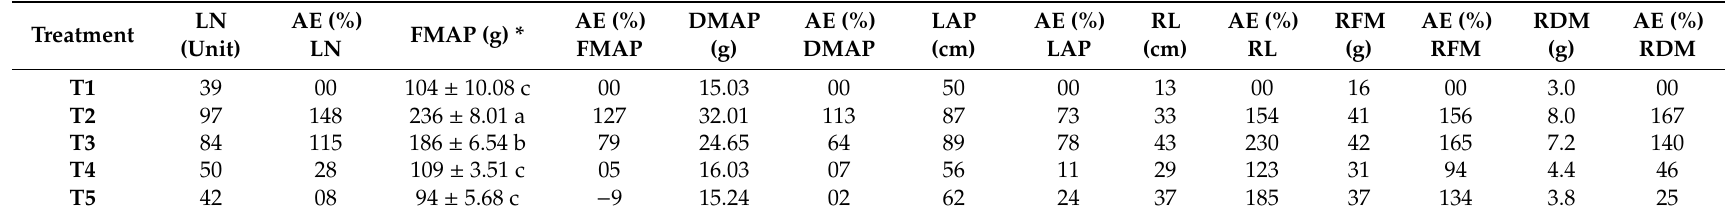
Table 3. Number of leaves (LN), fresh mass of the aerial part (FMAP), dry mass of the aerial part (DMAP), length of the aerial part (LAP), root length (RL), root fresh mass (RFM) and root dry mass (RDM), average of 3 repetitions / treatment and the agronomic e ffi ciency index (AEI, %) of each evaluated characteristic of the pepper plants.